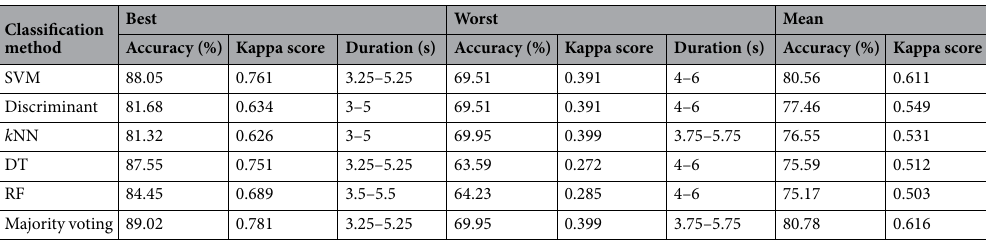
Table 10. Classification accuracy and kappa score results for two-second segments using Stockwell transform for datset IV-2b.